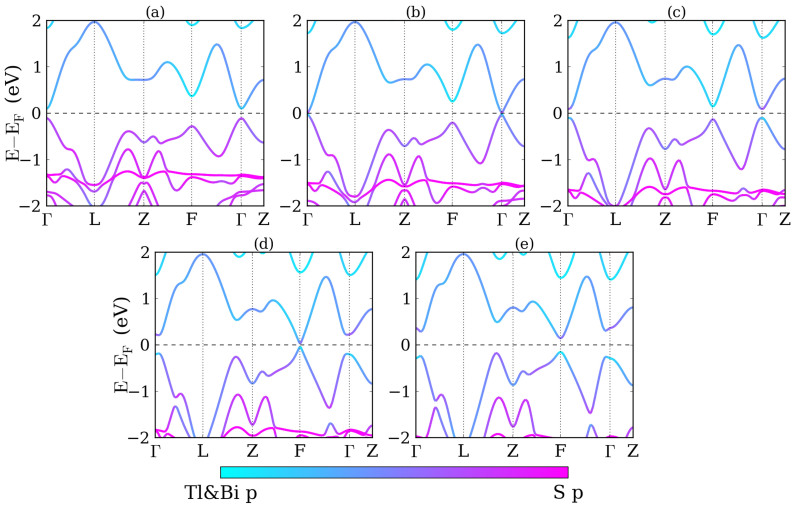
Band structures of TlBiS2 for (a) −2 GPa, (b) 0 GPa, (c) 2 GPa, (d) 5 GPa, and (e) 8 GPa hydrostatic pressure.